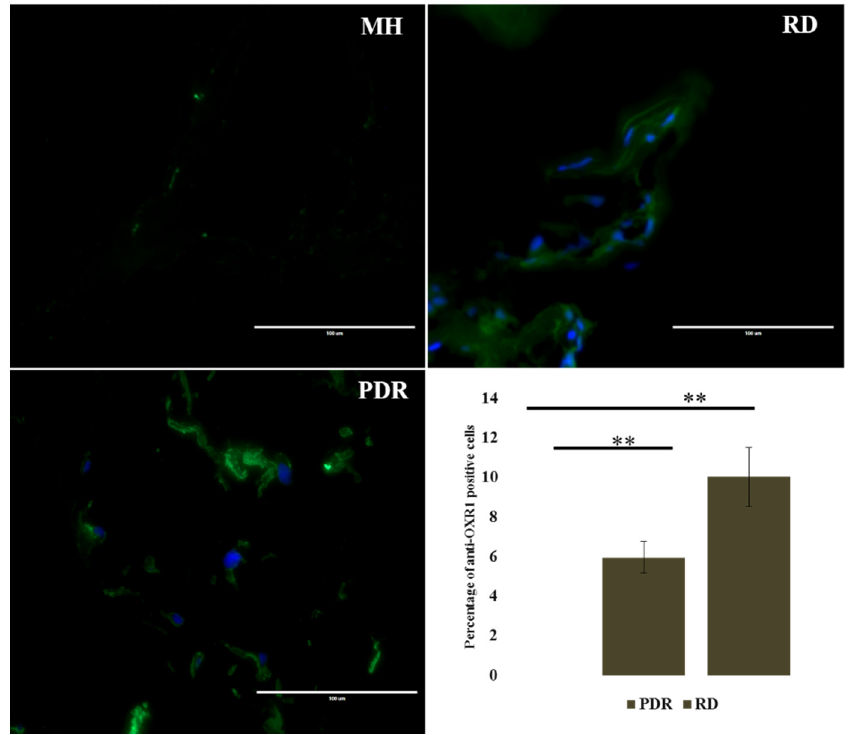
Figure 4. Representative images of IHC showing the expression of OXR1 in MH, RD, and PDR. The graph shows the mean percentage of OXR1 positive cells for each pathological condition ( n = 3) (scale bar; 100 μ m) ** p -value <0.05.